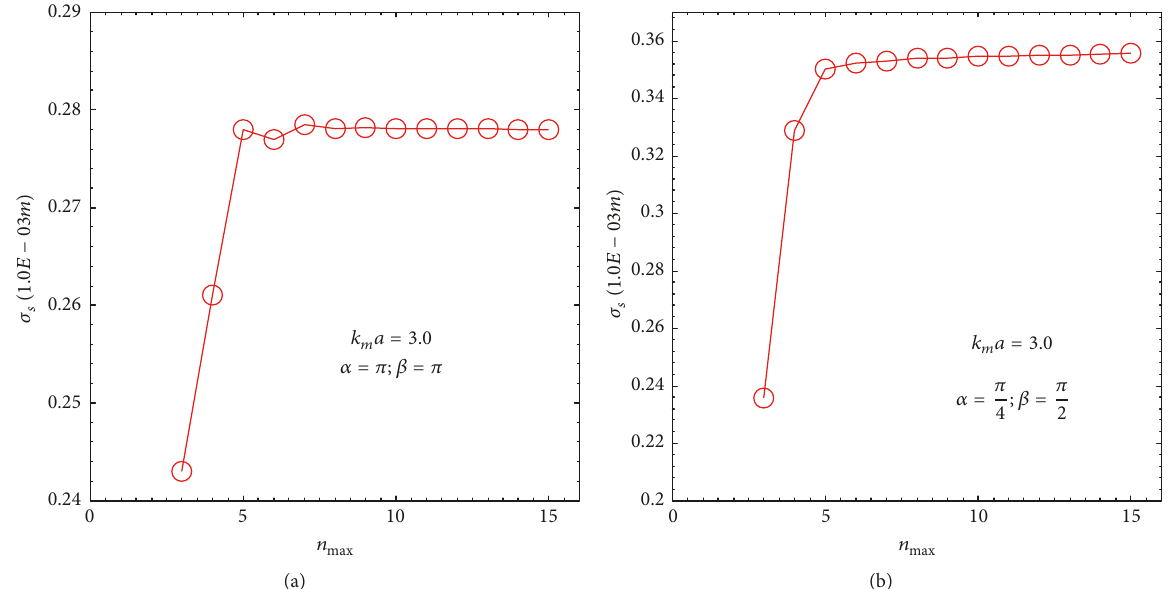
Figure 4: Convergence analysis of the CP method through two examples with a partial imperfectly bonded interface: (a) 𝛼 = 𝜋 , 𝛽 = 𝜋 and (b) 𝛼 = 𝜋/4 , 𝛽 = 𝜋/2 .